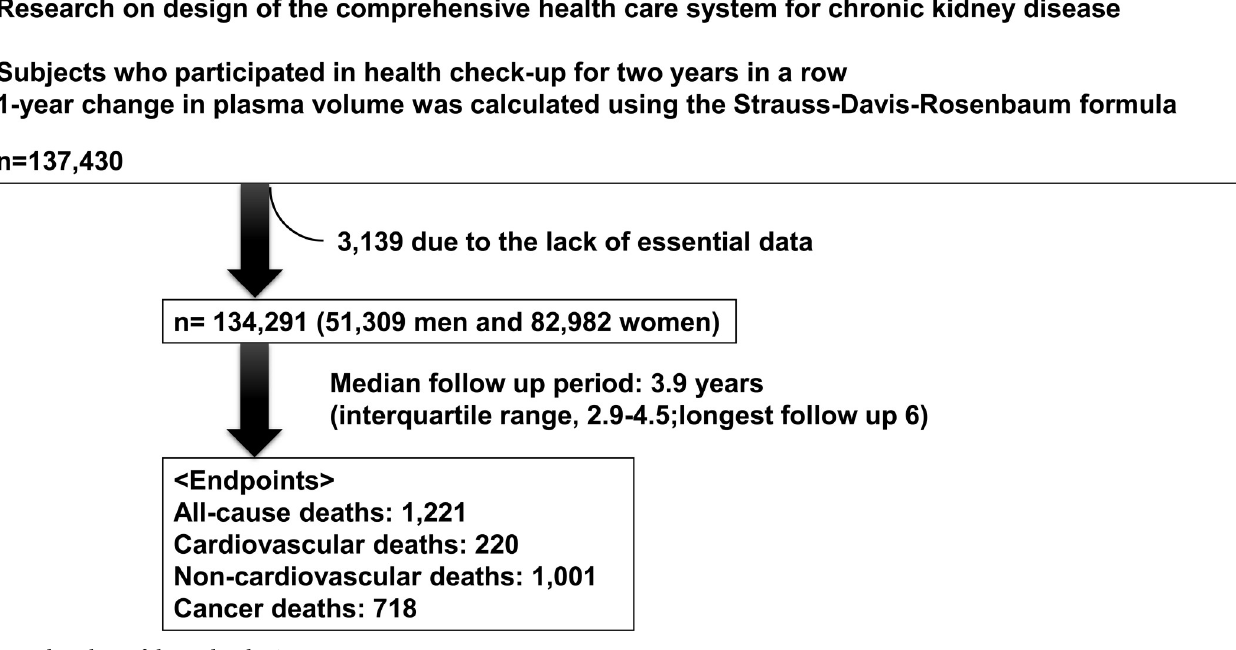
Fig 1. Flow chart of the study selection